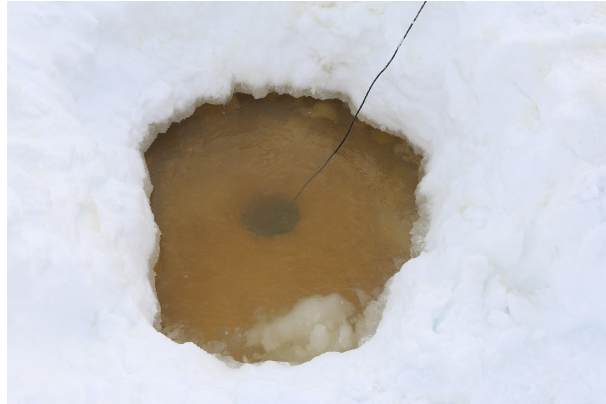
Figure 13. Liquid water on ice during lake ice drilling in central Ya- mal, April 2019. The lake in the photo is termed LK-013, observed and drilled on 6 April 2019 (ca. 14:00 local time). The coordinates (WGS 84 geographic) are 70.262123 ◦ N, 68.884803 ◦ E. Ice thick- ness at the time of drilling was approximately